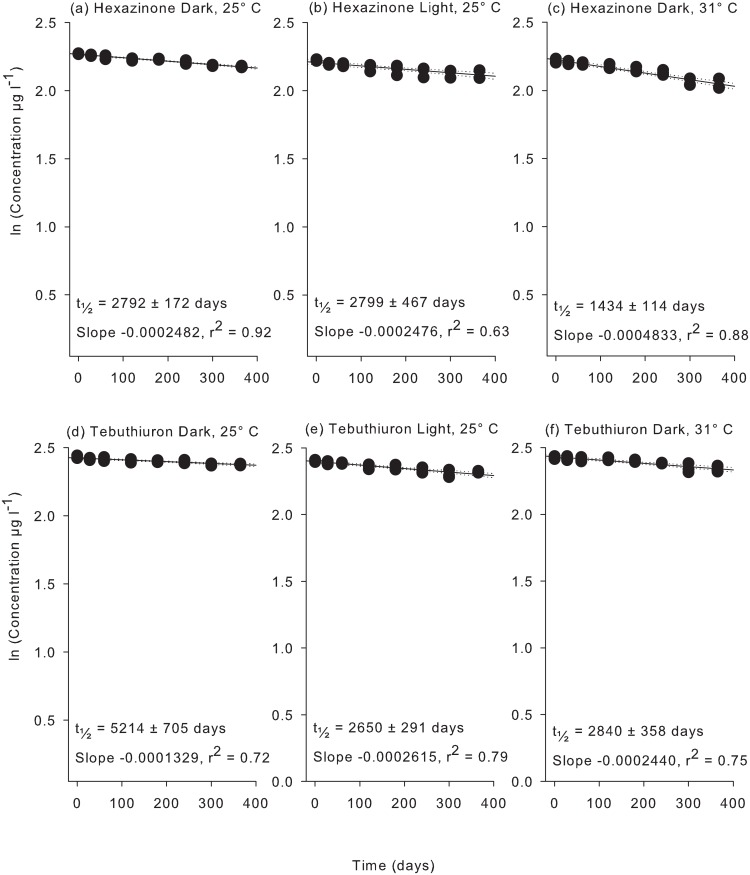
Experiment 2 half-life results for hexazinone and tebuthiuron.ln(x) concentration of individual herbicide treatments: (a) hexazinone dark 25°C, (b) hexazinone light 25°C, (c) hexazinone dark 31°C, (d) tebuthiuron dark 25°C, (e) tebuthiuron light 25°C, and (f) tebuthiuron dark 31°C over 365 days. Dashed lines represent 95% confidence intervals. Half-life reported ± SE.